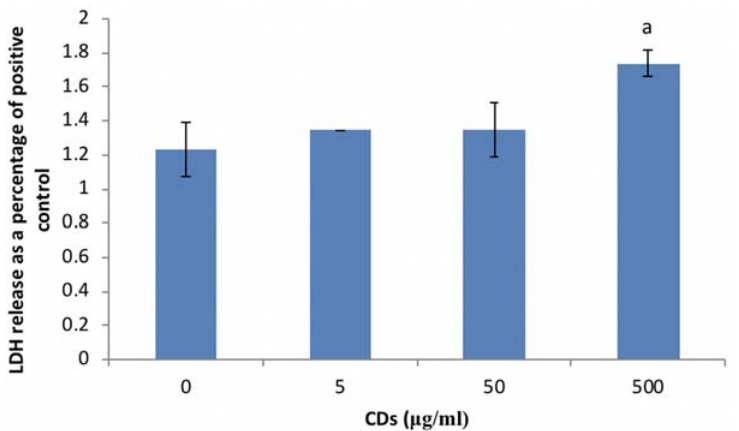
Figure 4. Cell viability of whole blood cells (WBCs) exposed to CDs. Data represents mean ± SD with n = 4. Bars marked with letters indicate significant difference ( p < 0.01) to control. Significance demarcated by a: significantly different ( p < 0.002) compared to 0 μ g/mL CD control.